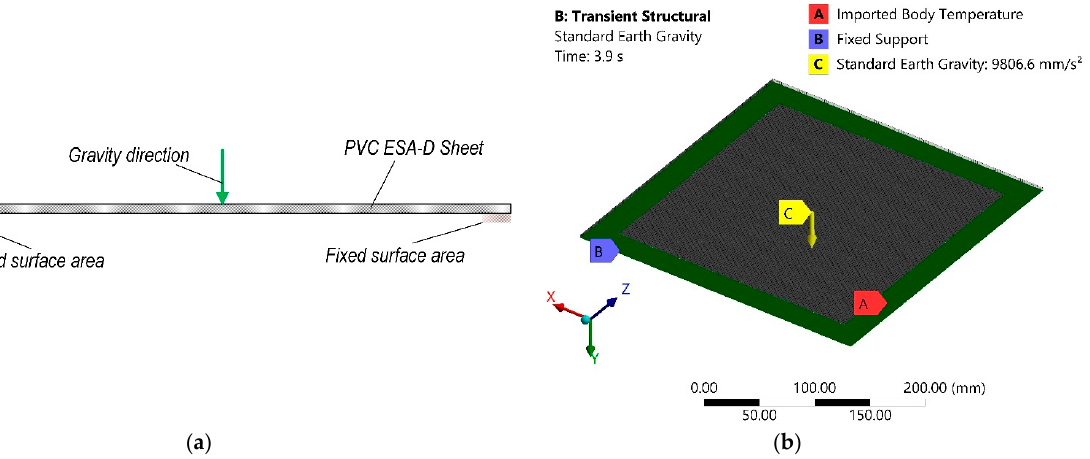
Figure 4. Transient structural numerical analysis: ( a ) scheme; ( b ) computational model with boundary conditions. FE model numerical simulation data of this stage are presented in Table 3. Table 3. FE numerical simulation data of the second stage of analysis.